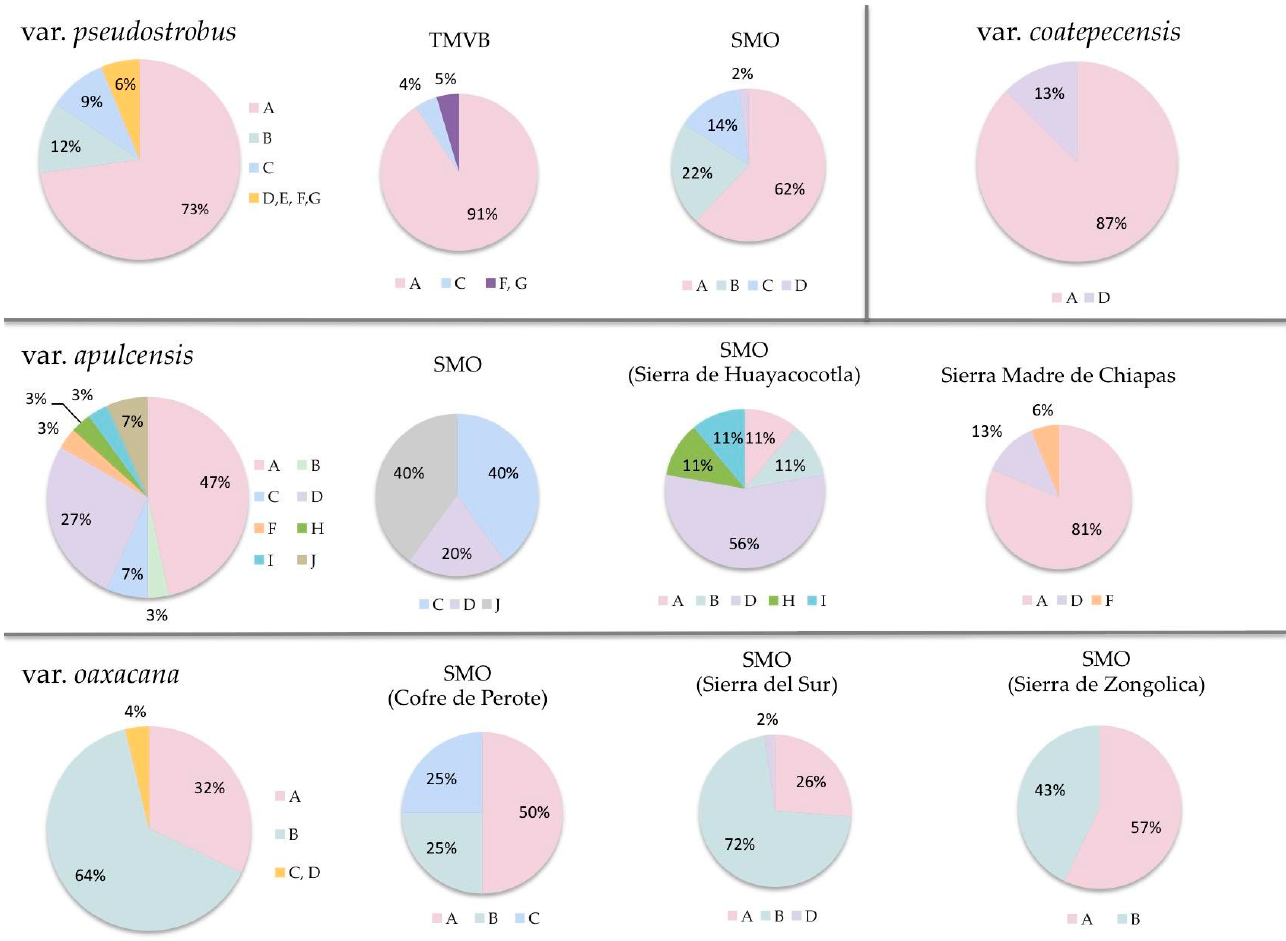
Figure 4. Haplotype frequencies found for the different varieties in the Trans-Mexican Volcanic Belt (TMVB), different regions of the Sierra Madre Oriental (SMO) and Sierra Madre de Chiapas.